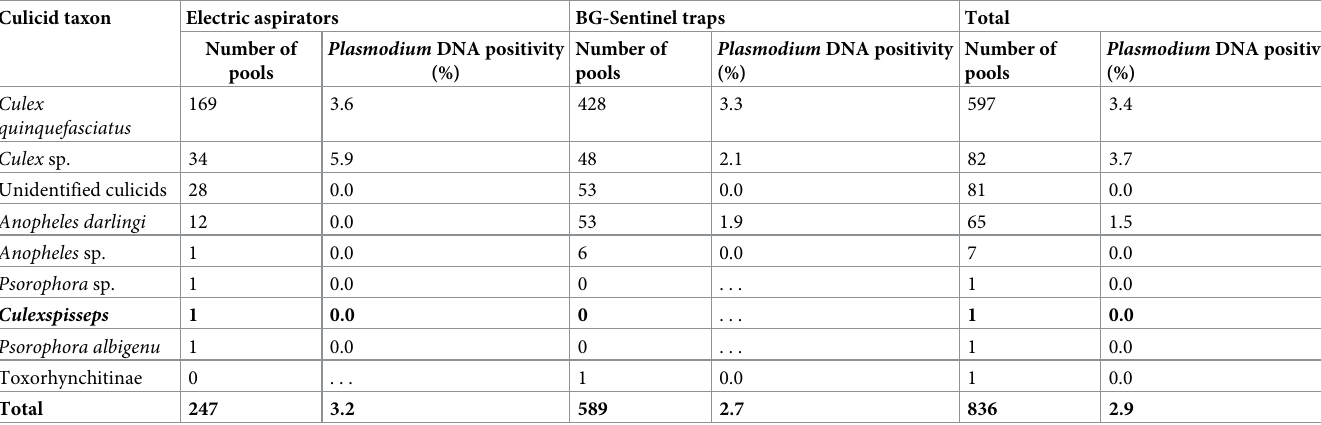
Table 4. Plasmodium DNA positivity in blood-engorged culicid pools according to